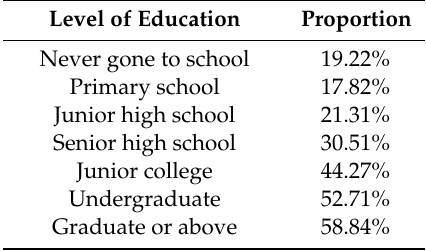
Table 1. The proportions of migrants with di ff erent levels of education who had settlement